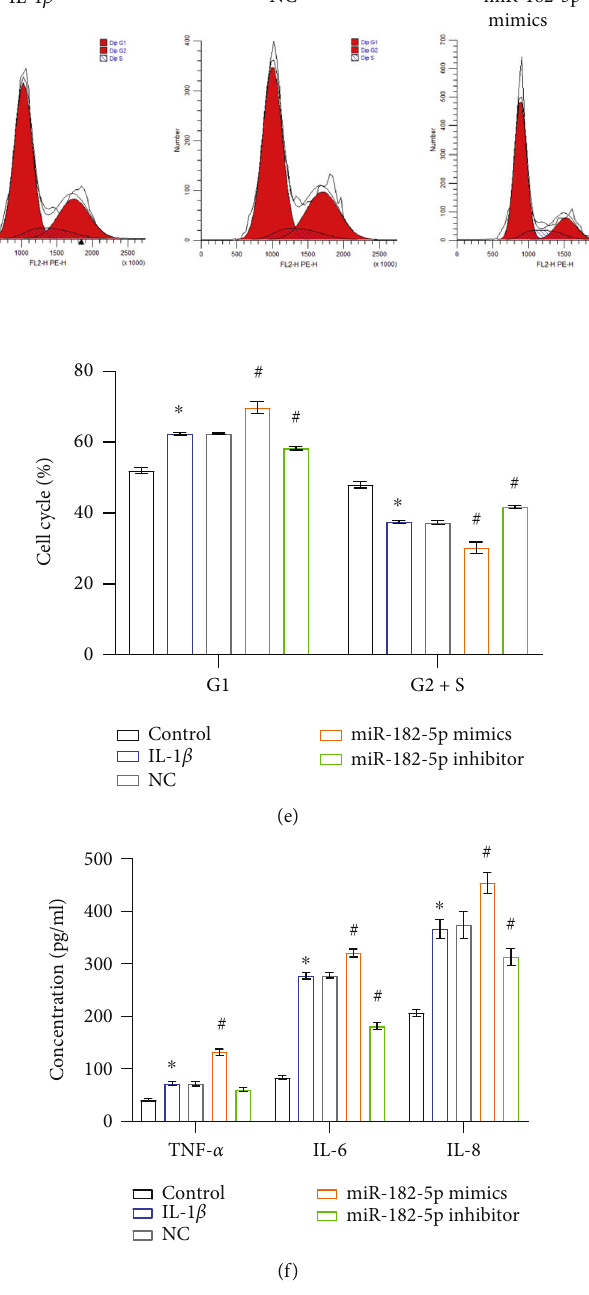
Figure 2: miR-182-5p inhibited chondrocyte proliferation and promoted apoptosis. (a) The gene expression of miR-182-5p. (b) CCK8 was used to determine the cell viability. (c) Photos and analysis of plate cloning of each group of cells. Flow cytometer was utilized to test the (d) apoptosis and (e) cell cycle. (f) The expression of in fl ammatory factors (TNF- α , IL-6, and IL-8) was evaluated by ELISA. * P < 0 : 05 vs. control. # P < 0 : 05 vs.